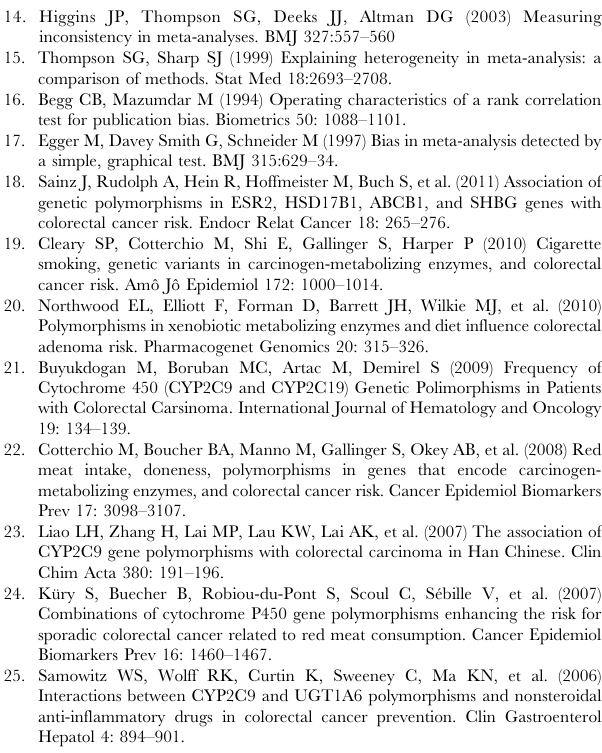
Figure S1 The association study selection process. (TIF) Figure S2 Result of sensitivity analyses for CYP2C9*2 carrier and CRC risk. (TIF) Figure S3 Result of sensitivity analyses for CYP2C9*3 carrier and CRC risk. (TIF) Figure S4 Funnel plot for the association between and CYP2C9 *2 carrier and colorectal cancer risk; Egger’s test was also performed to investigate the symmetry of the funnel plot ( P = 0.96). (TIF) Figure S5 Funnel plot for the association between and CYP2C9 *3 carrier and colorectal cancer risk; Egger’s test was also performed to investigate the symmetry of the funnel plot ( P =